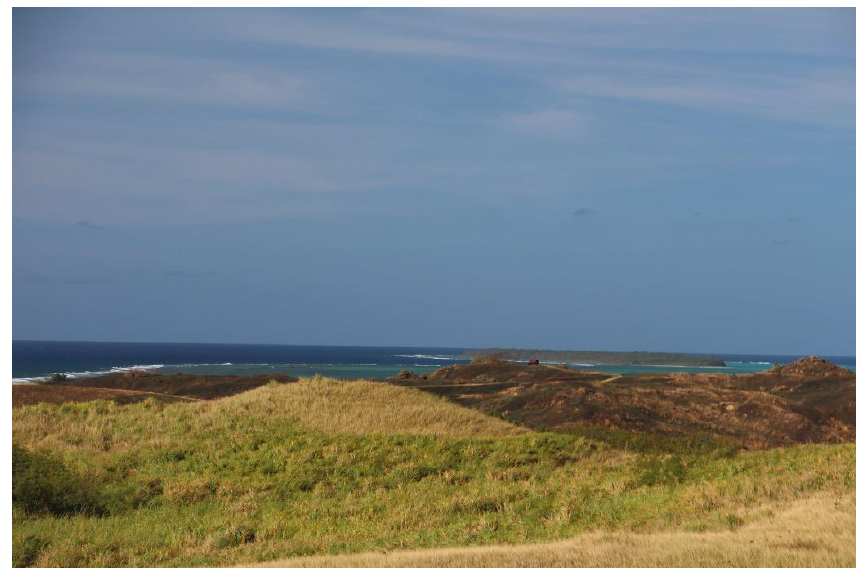
Figure 2. Grasslands of southern Guam showing coral reefs downslope from burned areas.